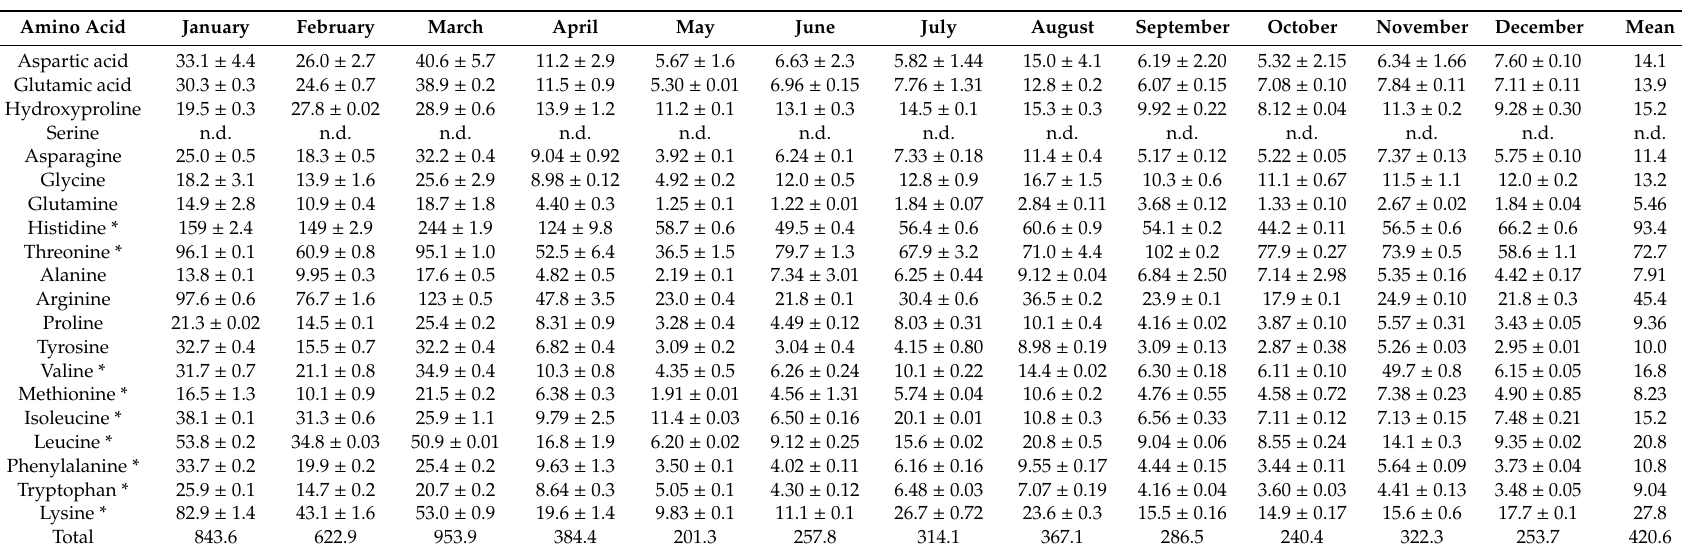
Table 2. Changes in free amino acid content in sardines over 12 months (mg / 100 g wet weight) ( n =